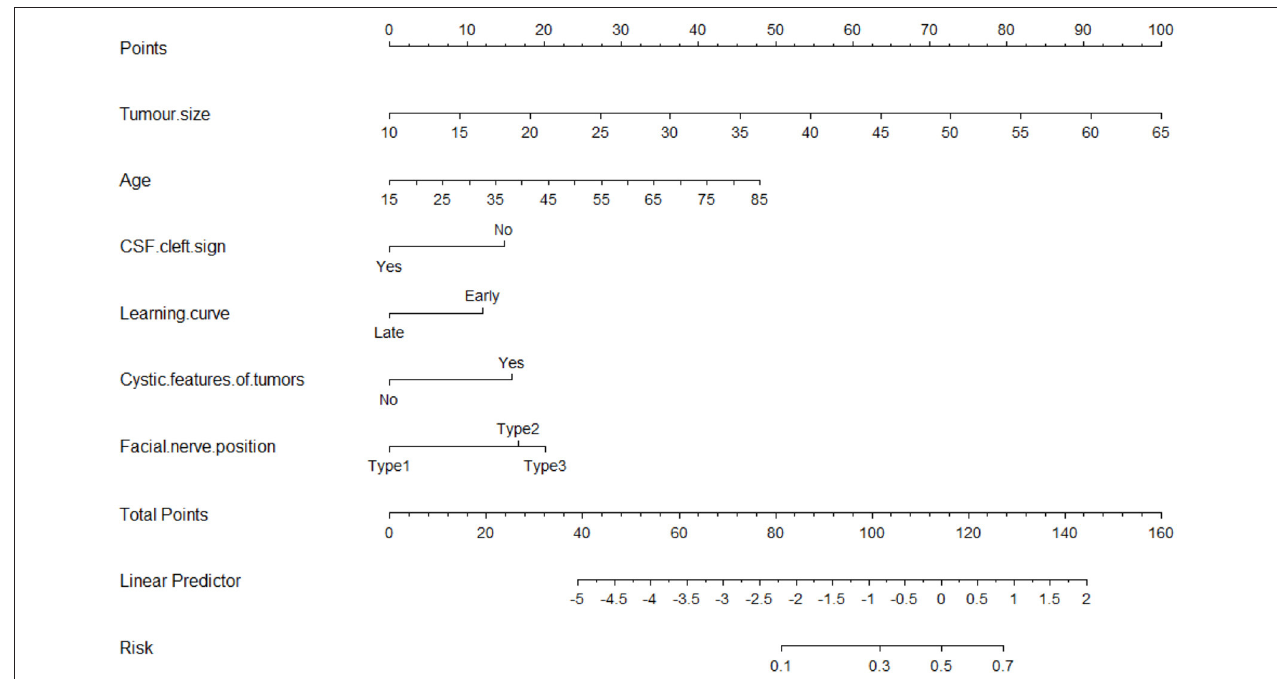
FIGURE 2 | The nomogram for predicting tumor size, age, cystic features of tumors, FN position, learning curve, and CSF cleft sign to the nerve for facial nerve (FN) outcomes after surgical resection of vestibular schwannoma.